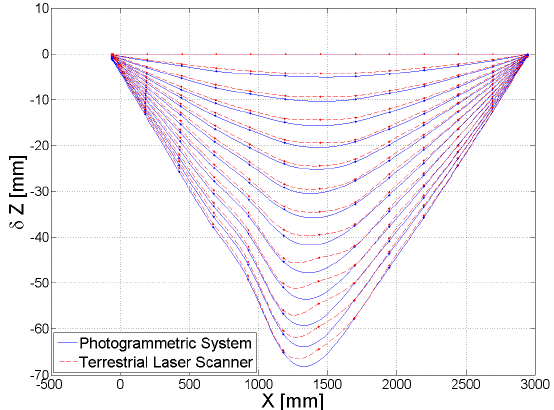
Figure 11. Cubic spline plots of the beam deflections computed using the photogrammetric reconstruction vs. the terrestrial laser scanner for the first experiment